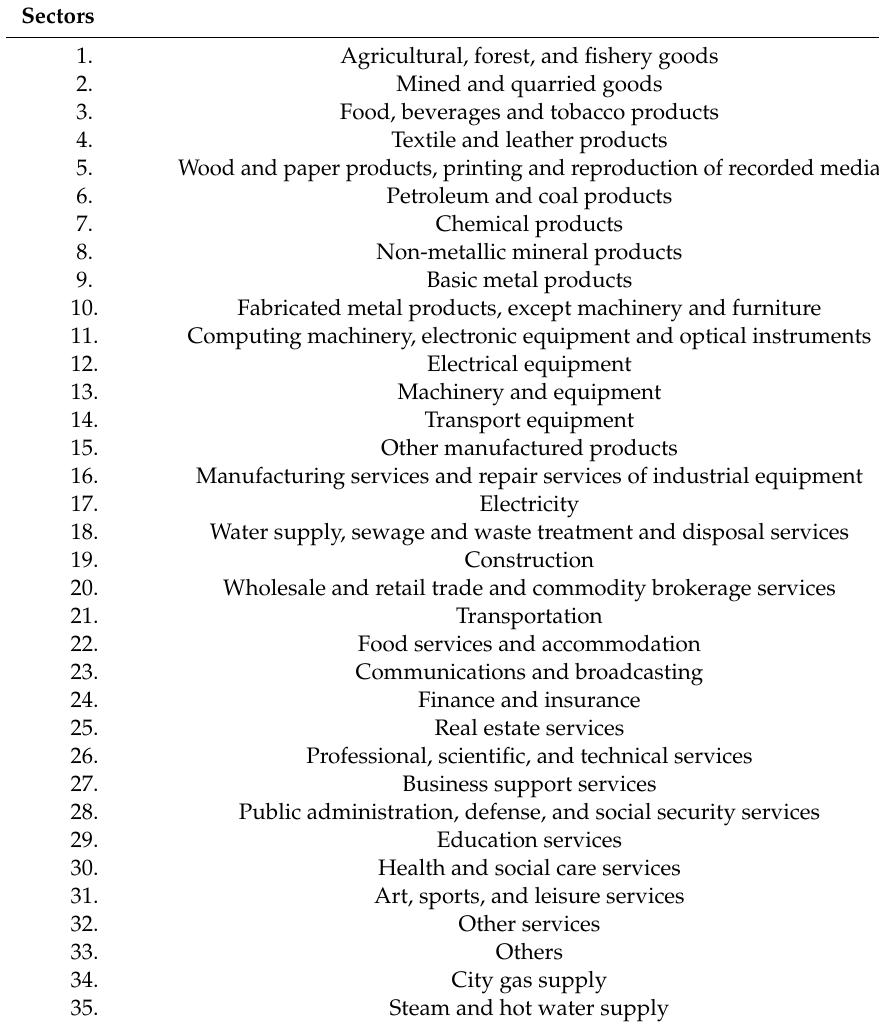
Table 1. Sector classification adopted in this